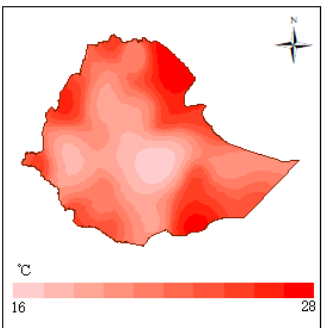
Figure 6. High-resolution map of the mean annual air temperature in Ethiopia during 1990–2020 generated using the hybrid of MLPs.